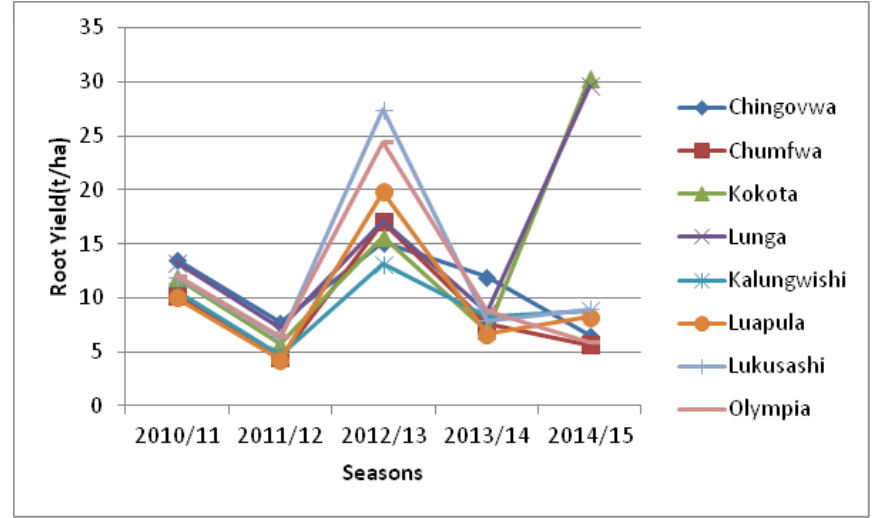
Figure 1: Variability in root yield among sweetpotato genotypes in different seasons